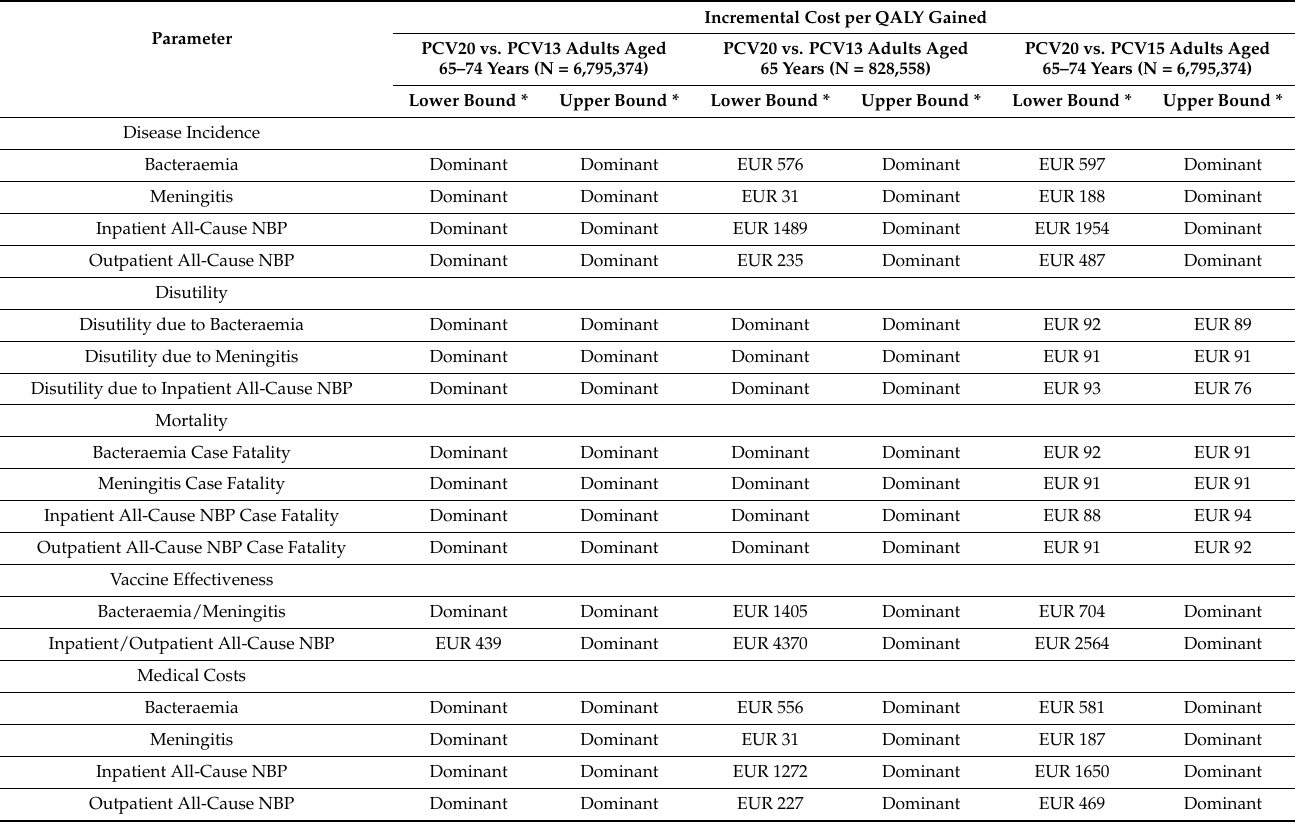
Table 9. One-way sensitivity analyses for cost-effectiveness.